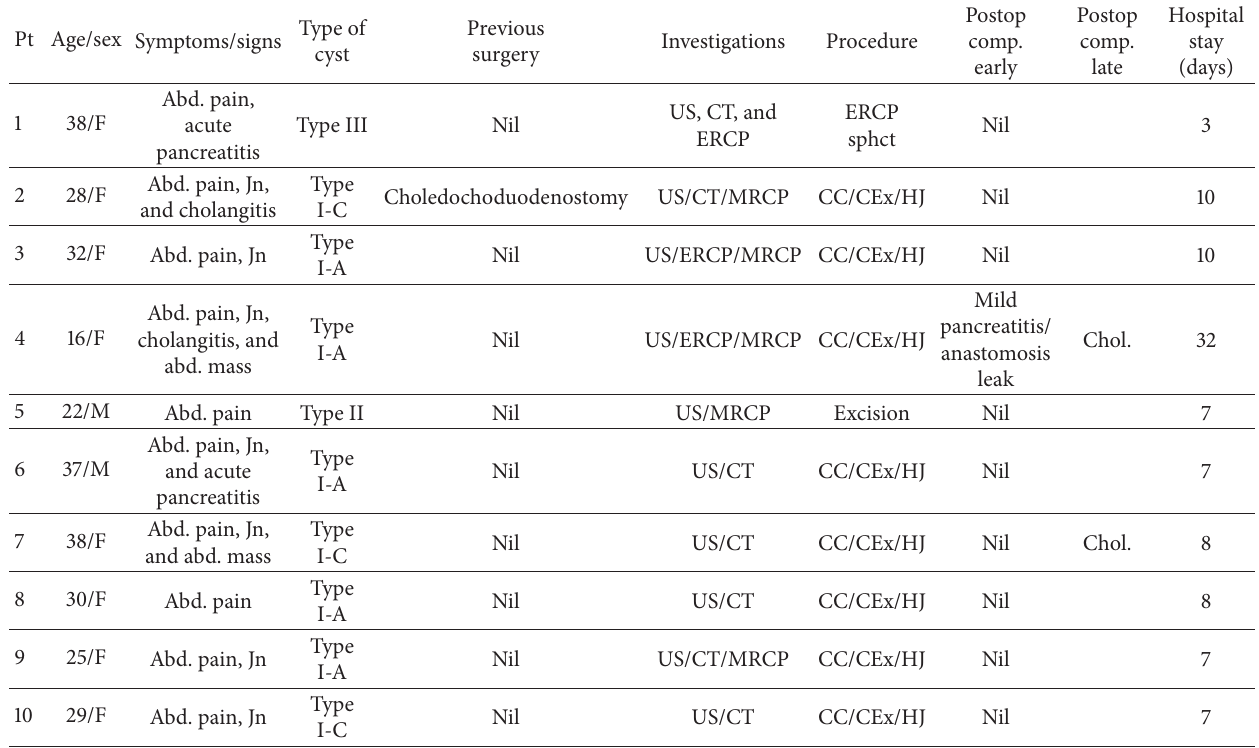
Table 1: Demographic details, management, and outcome of patients.